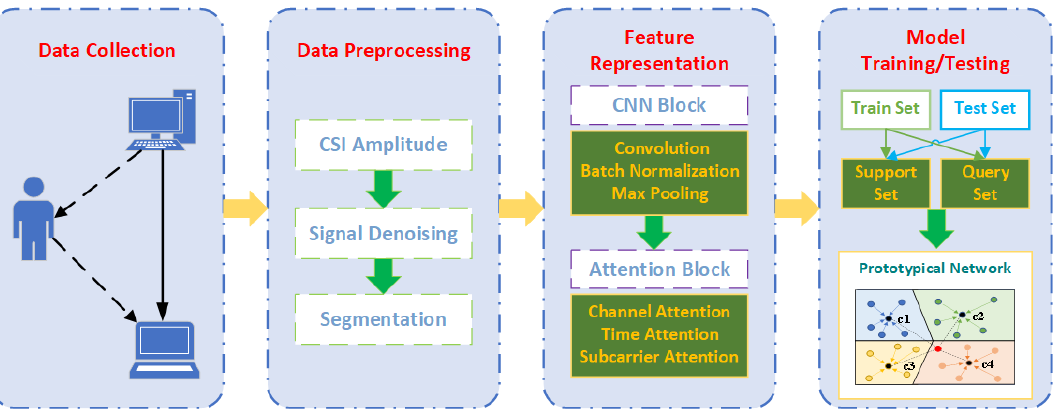
Figure 6. The system architecture for